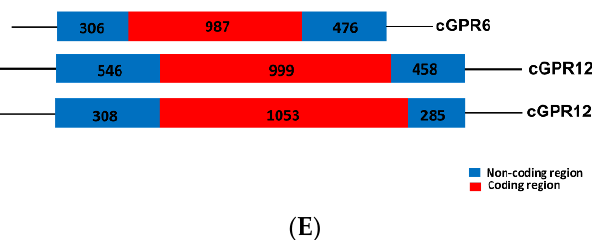
Figure 1. Amino acid sequence alignment of G protein-coupled receptor 3 (GPR3), GPR6, GPR12, and GPR12L in vertebrates. ( A ) Alignment of the cloned duck (d-)/zebrafish (zf-)/pig (p-) GPR3 with that of humans (hGPR3, NP_005272.1), giant pandas (gpGPR3, XP_034503372.1) and spotted gars (sgGPR3, XP_015204111.1); ( B ) Alignment of the cloned chicken(c-)/duck(d-)/zebrafish(zf-)/pig(p-) GPR6 with that of humans (hGPR6, NP_005275.1), giant pandas (gpGPR6, XP_002925693.2), and spotted gars (sgGPR6, XP_006626355.1); ( C ) Alignment of the cloned chicken (c-)/duck (d-)/zebrafish (zf-)/pig (p-) GPR12 with that of humans (hGPR12, NP_005279.1), giant pandas (gpGPR12, XP_002924260.1), and spotted gars (sgGPR12, XP_015196669.1); ( D ) Alignment of the cloned chicken (c-)/duck (d-)/zebrafish (zf-) GPR12L with that of anole lizard (lGPR12L, XP_028571577.1) and spotted gars (sgGPR12L, XP_015206591.1). The seven transmembrane domains (TMD1–7) and N -glycosylation sites (NXT/S) are shaded; the XXXWD motif is boxed; conserved motifs (DRY, XWXP, and NPXXY) are marked by arrowheads; ( E ) Exon–intron organization of chicken GPR6 , GPR12 , and GPR12L . The red boxes indicate the coding region, and the numbers inside denote the size (in bp); while the blue box represents the untranslated regions, (UTRs) and the number within specifies the size (in bp).